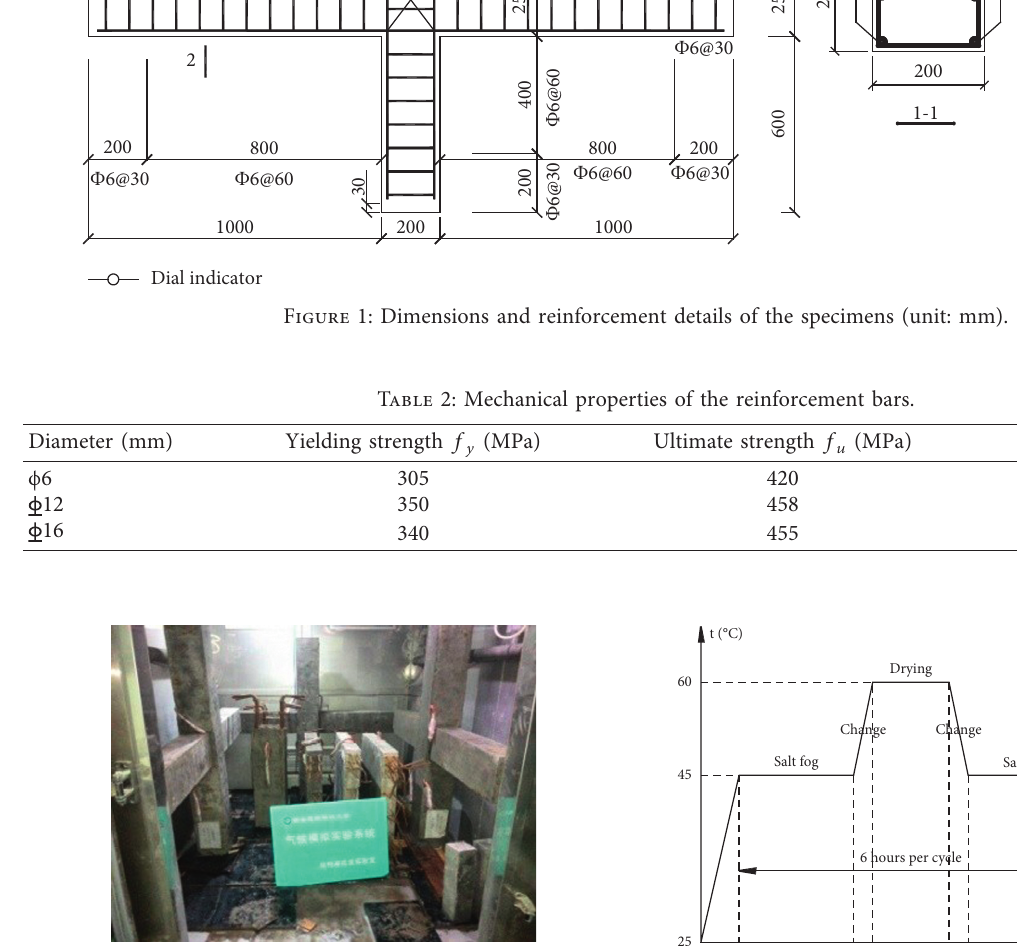
Figure 2: Photo of salt spray corrosion testing process.